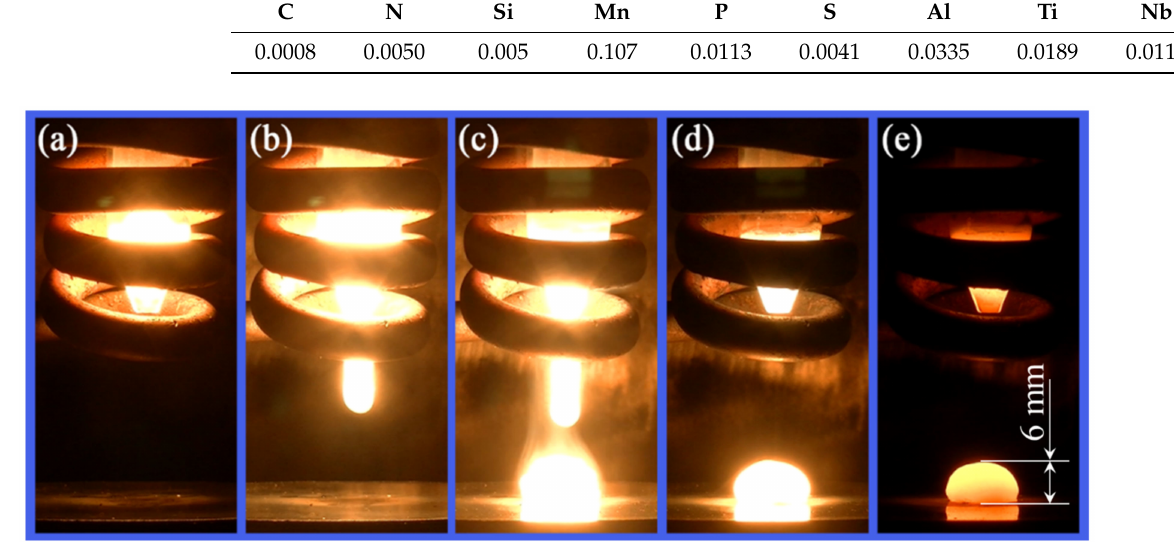
Figure 2. Ejection and solidification process during droplet solidification test: ( a ) melting of the steel sample at target temperature, ( b , c ) ejection of liquid steel, ( d , e ) solidification on chill copper mold.